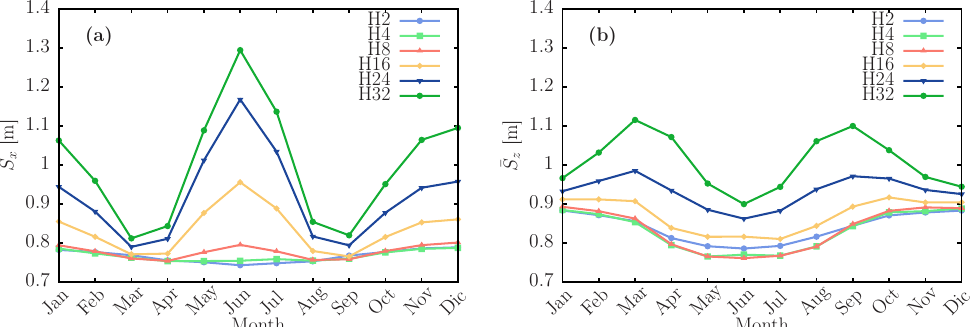
Figure 10. Variation throughout the year of the daily standard deviations of the concentrated radiative flux distribution ¯ S x and ¯ S z along the x ( a ) and z ( b ) axes, respectively, for arrays with different number of facets, placed at a distance of 2 h (70 m).